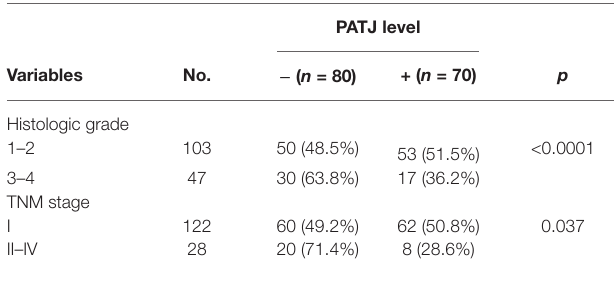
TABLE 1 | Association of PATJ expression with clinicopathological parameters from ccRCC